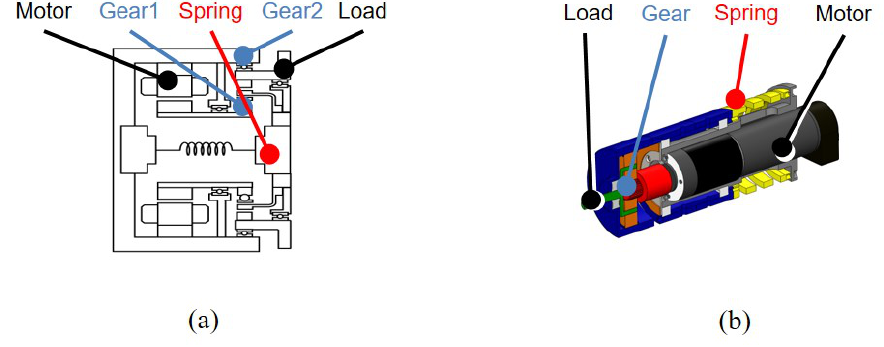
Figure 9. Example models of TFSEA. ( a ) Differential Elastic Actuator (DEA) and ( b ) compact Planetary-geared Elastic Actuator